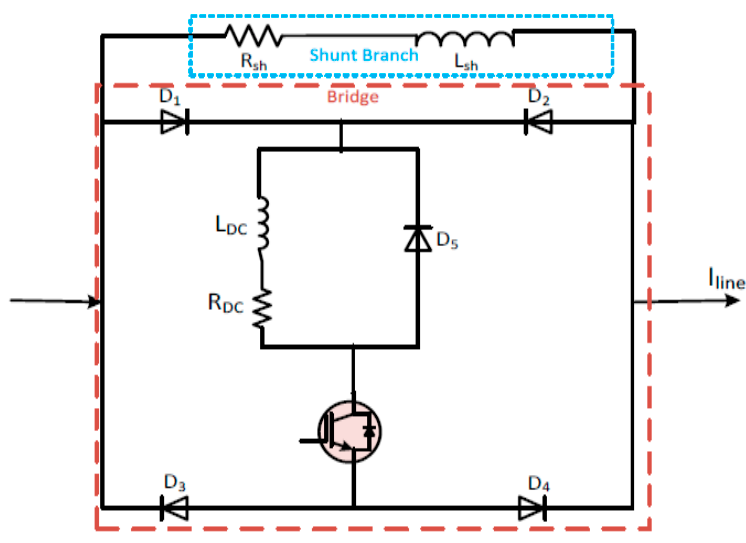
Figure 18. Bridge-type FCL.